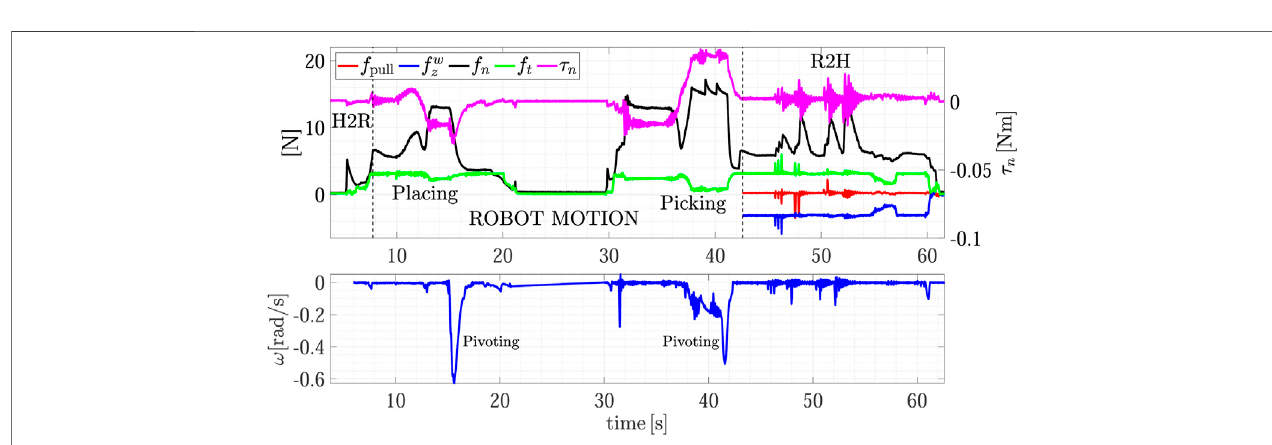
Frontiers in Robotics and AI |